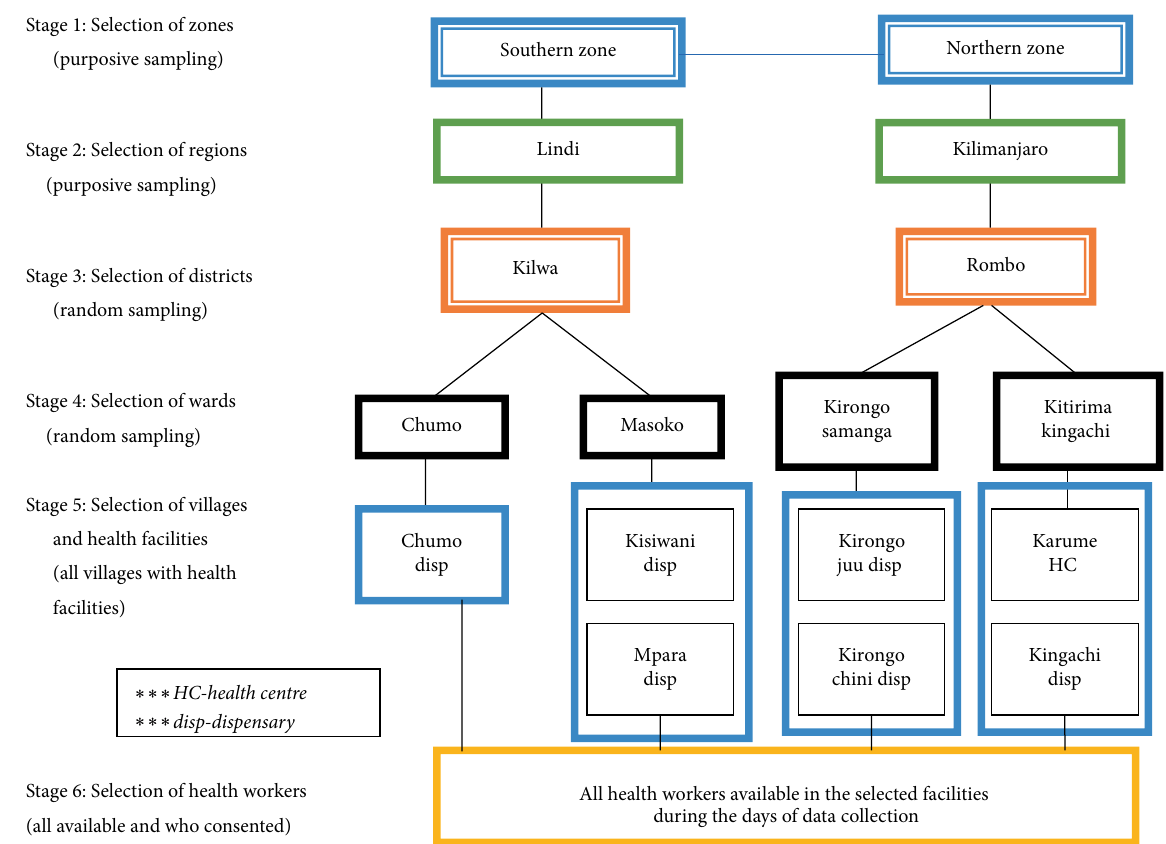
Figure 1: Multi-stage sampling.